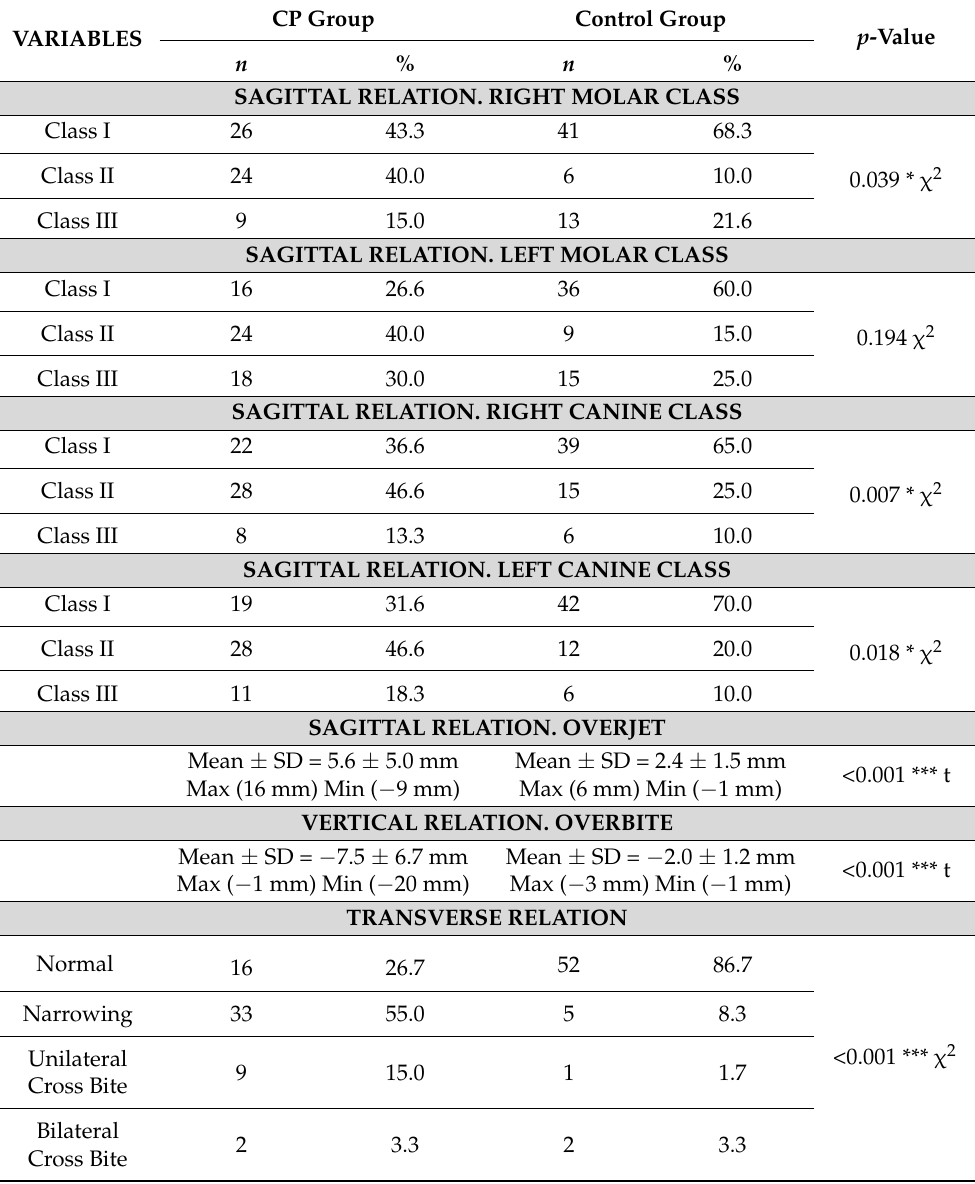
Table 3. Relationship of the intraoral occlusal measurements in the three spatial planes—sagittal, vertical and transverse—between the two groups: Cerebral Palsy (CP) and Control Group. χ 2 : chi-squared test; t: Student’s t -test; p < 0.05 *; p < 0.001 ***.